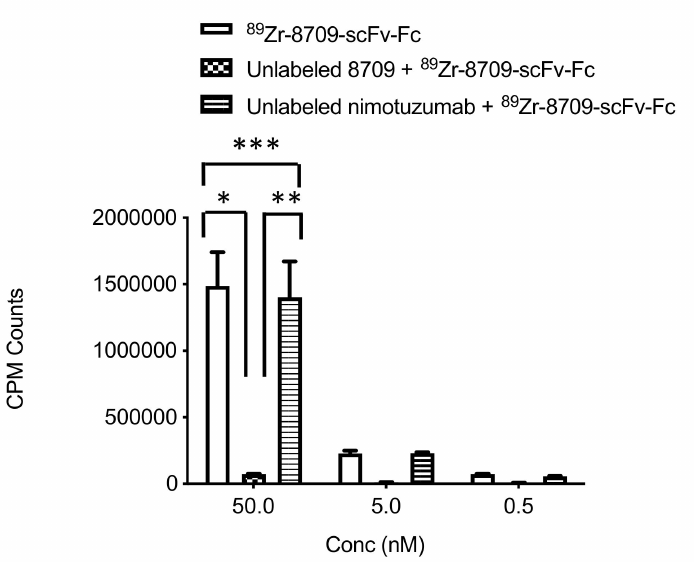
Figure 2. Competitive binding assay of 89 Zr-8709-scFv-Fc in EGFR positive DLD-1 cells at different concentration 50 nM, 5 nM and 0.5 nM in the presence of unlabeled 8709-scFv-Fc or unlabeled nimotuzumab (domain III binder). p < 0.05 for * and ** indicating statistical significance, while p > 0.05 for *** at 50 nM concentration, and as well at 5 and 0.5 nM. 89 Zr-8709-scFv-Fc exhibited a bi-phasic clearance with a fast (distribution) half-life